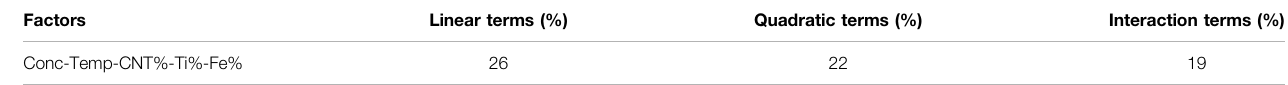
TABLE 4 | Prediction of Co retention (%REP) by principal component regression while including all possible interactions.